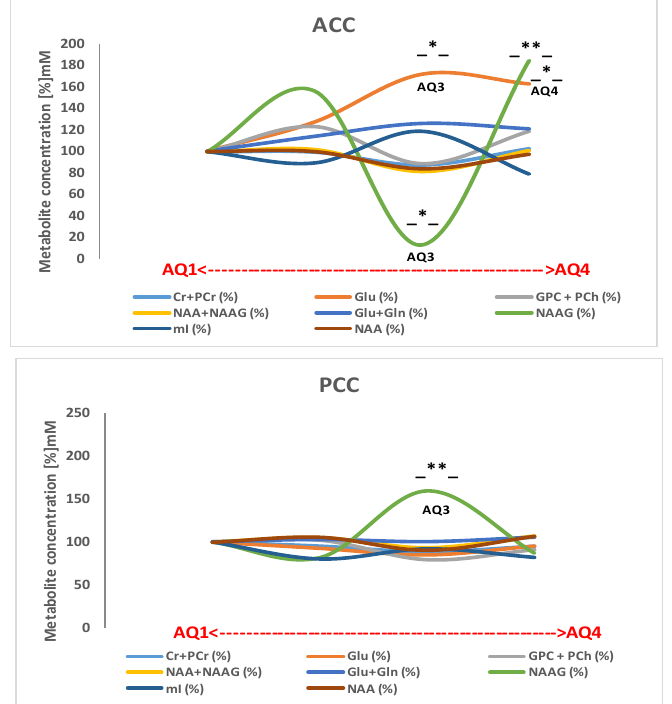
Figure 2. Absolute concentration (mM) patterns of the different metabolites detected in the ACC and PCC in all AQ indexes (AQ1 = 28.3%, n = 17; AQ2 = 43.3%, n = 26; AQ3 = 10.0%, n = 9; AQ4 = 18.3%, n = 13) as a marker of ASD severity. The X-axis trajectories within the AQ range are represented in the normalized graph. * p < 0.05.- *-, - **-; significant at p < 0.05; 0.01; respectively.